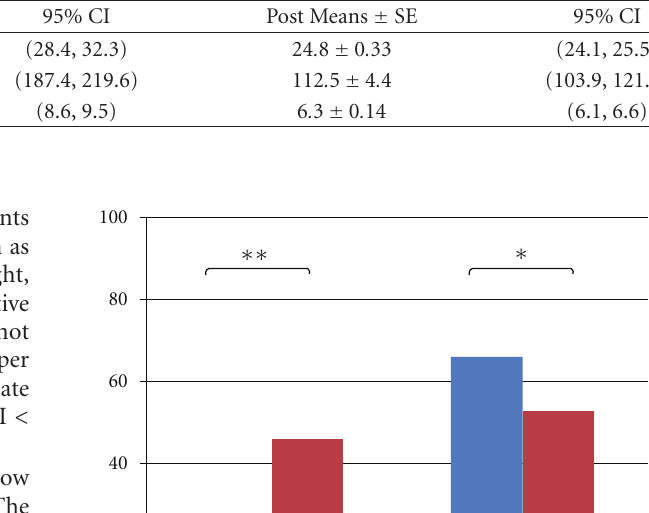
Table 3: Mean estimation of BMI, FPG, and HbA1c before and after metabolic surgery. Combined data from 18 existing bariatric studies.